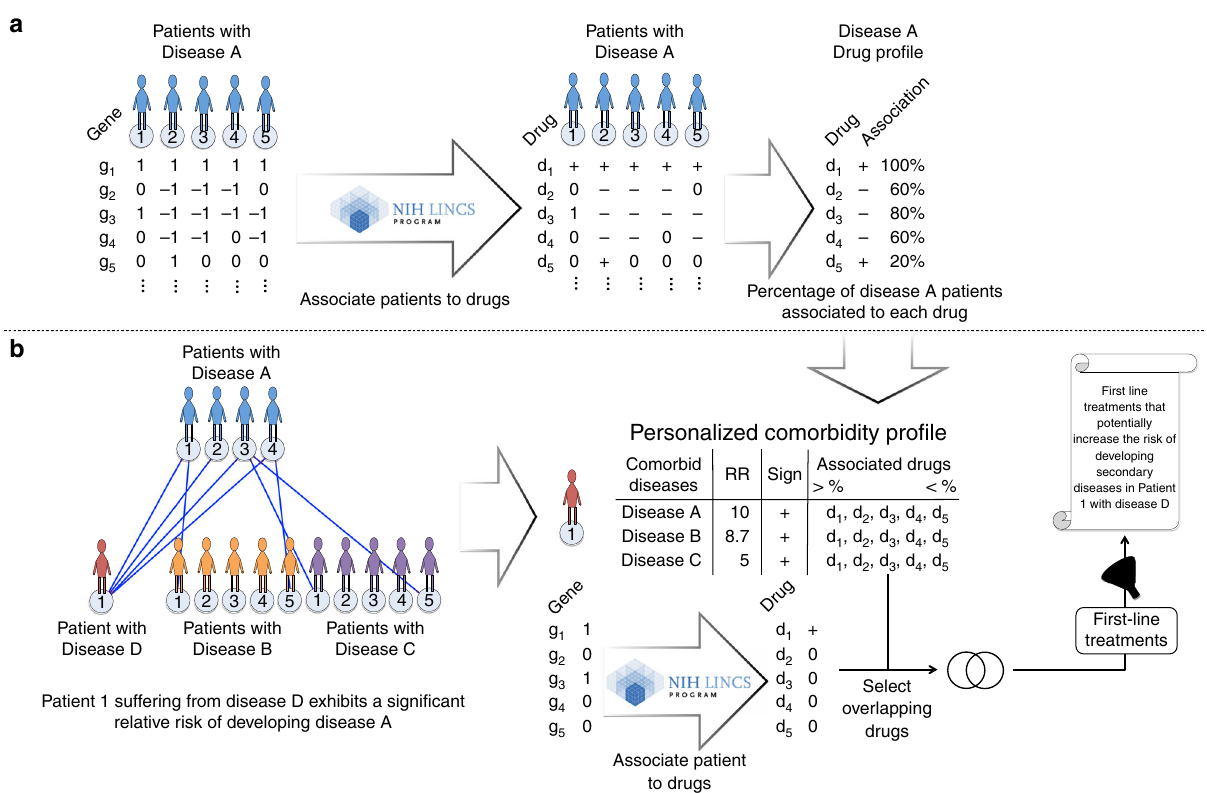
Overlaps between pairs of patients were assessed by one-tailed Fisher ’ s exact tests on lists of DEGs. Two patients are positively connected if they present signi fi cant overlaps between genes deregulated in the same direction (both up- and down- regulated). On the other hand, two patients are negatively connected if they present signi fi cant overlaps between genes upregulated in one patient and downregulated in the other one, and vice versa. If both types of signi fi cant overlaps are detected in the comparison (e.g. signi fi cant overlaps between genes up- and downregulated in the two patients, and between genes upregulated in one patient and downregulated in the other one), we considered there is no link between those patients. This condition removes 55,086 positive and 24,950 negative potential interactions between patients, that is 2% and 15% of the positive and negative interactions, respectively (Supplementary Fig. 10). Then, we looked for the one-tailed Fisher ’ s exact test threshold that did not produce random interactions. To this end, we generated 1000 patients randomly selecting 500 genes as up- and 500 genes as downregulated. We calculated the similarities (both positive and negative) between the generated patients varying the Fisher ’ s exact test threshold. We repeated this process 100 times and calculated the mean number of patient interactions (independently of the direction of the interaction). As expected, the number of detected interactions in this randomized set decreased while decreasing the threshold (Supplementary Fig. 11). Based on the obtained results, we generated the patient similarity network calculating patient − patient interactions using an FDR threshold of 0.0001. We repeated the analysis varying the number of DEGs selected (100, 200, 300, 400, 1000, 1500, 2000, 2500, 3000, 3500, 4000, 4500, 5000), obtaining for each of them the optimal threshold to avoid detecting random interactions (Supplementary Fig. 12). Relative Molecular Similarity estimates . For each pair of diseases, we consider a contingency table (Table 1) counting the number of positive interactions con- necting patients from the two diseases and the ones connecting one of the diseases with other ones.